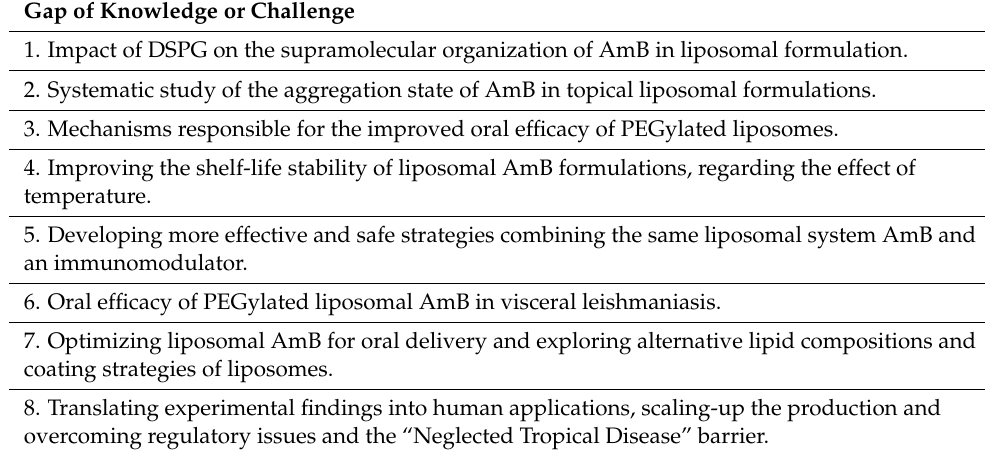
Table 3. Gaps of knowledge or challenges to be addressed in future investigations of liposomal AmB